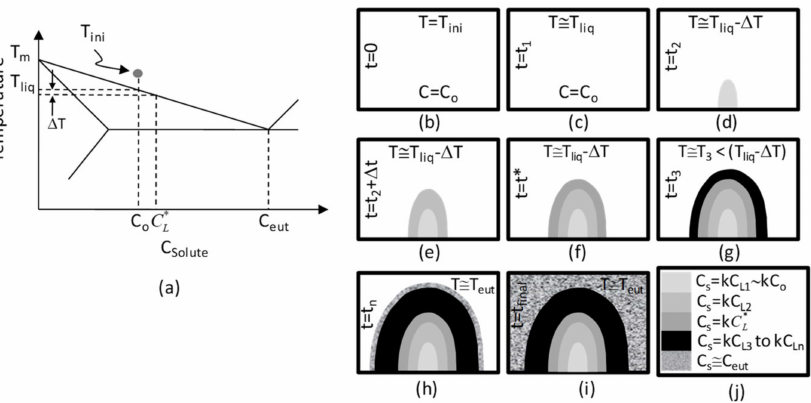
Figure 4. Schematic of the steps involved during uni-directional upward solidification of a binary alloy from a superheat temperature T ini to T eut . ( a ) schematic of binary alloy phase diagram, ( b – i ) vari- ous steps during solidification with increments of time in one CV and ( j ) index showing concentration of the various shades of solid phases in ( b – i ).